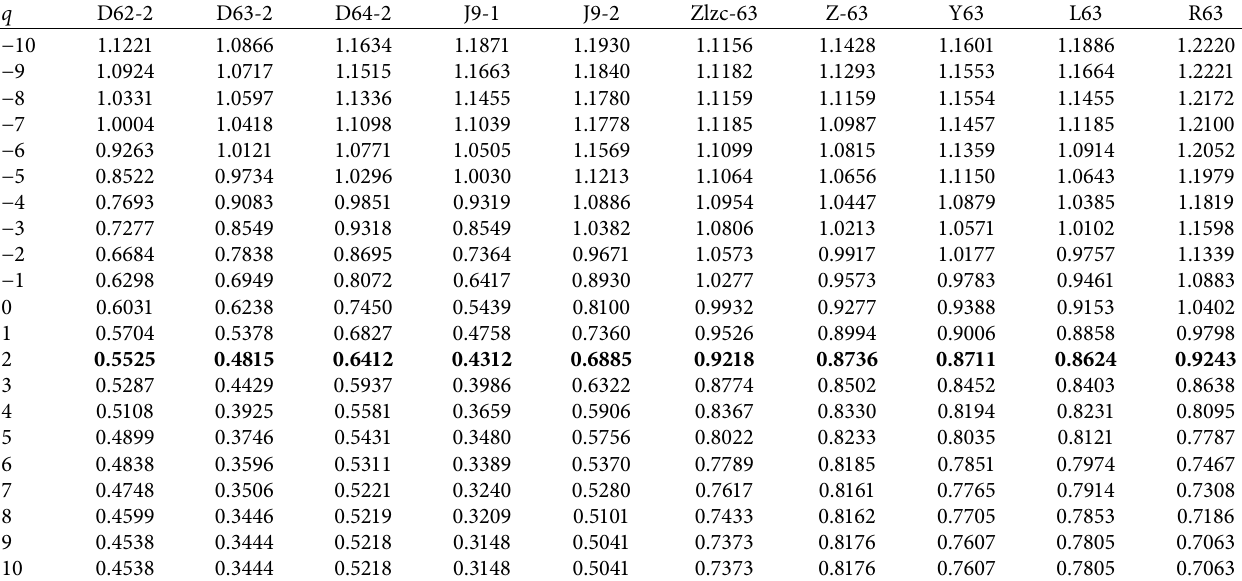
Table 4: Generalized Hurst